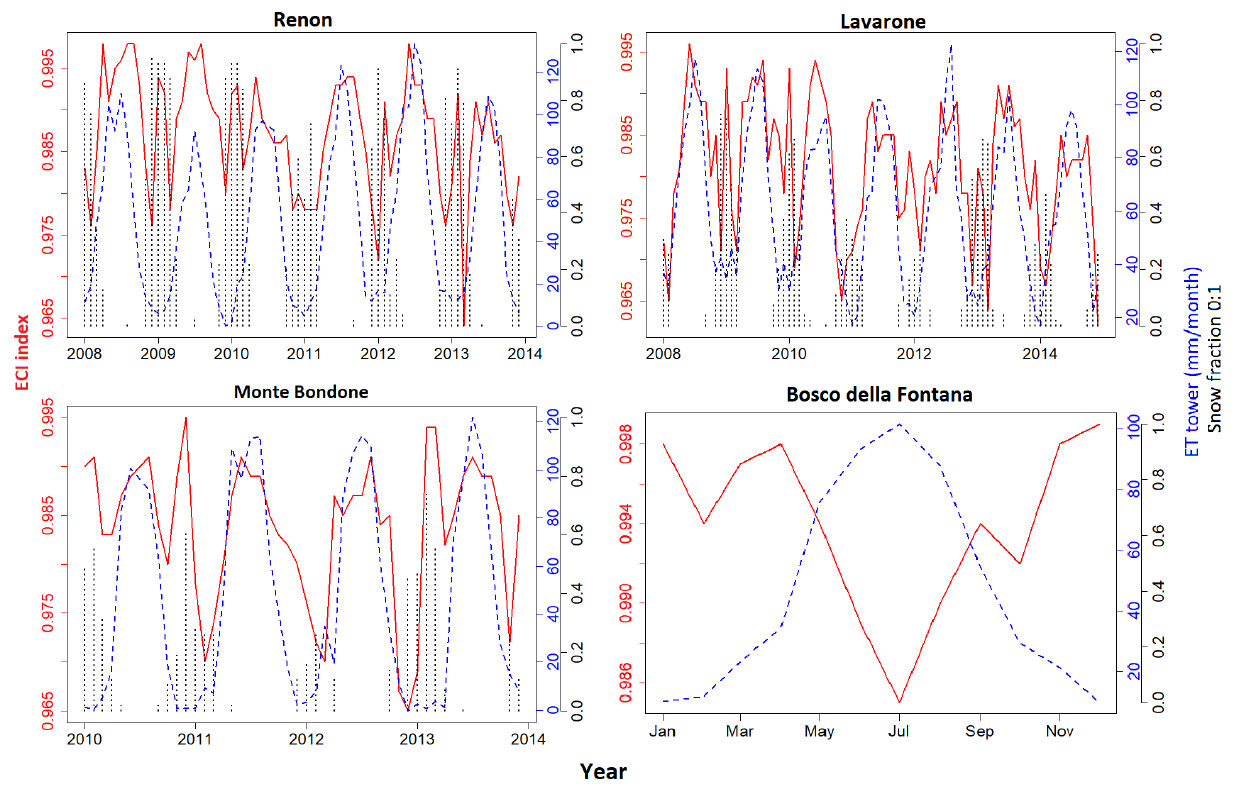
Figure 3. Relationship between the ET (ET tower—blue line) and the monthly ECI (red